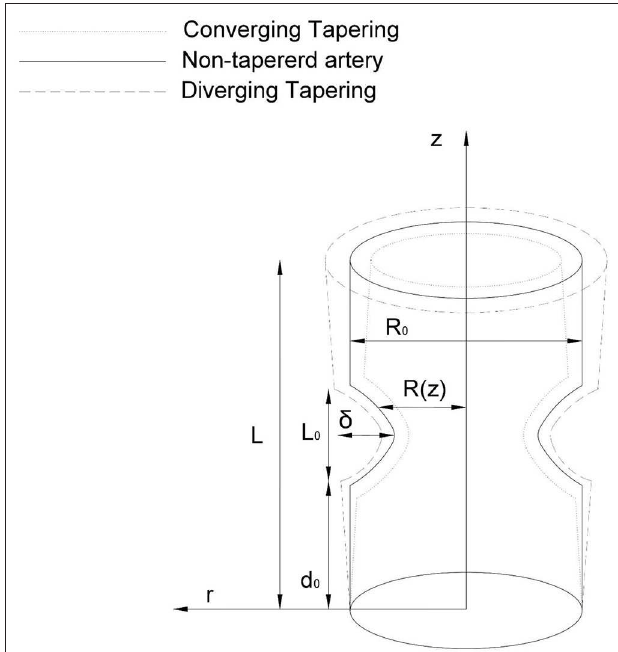
FIGURE 1 | Flow structure.